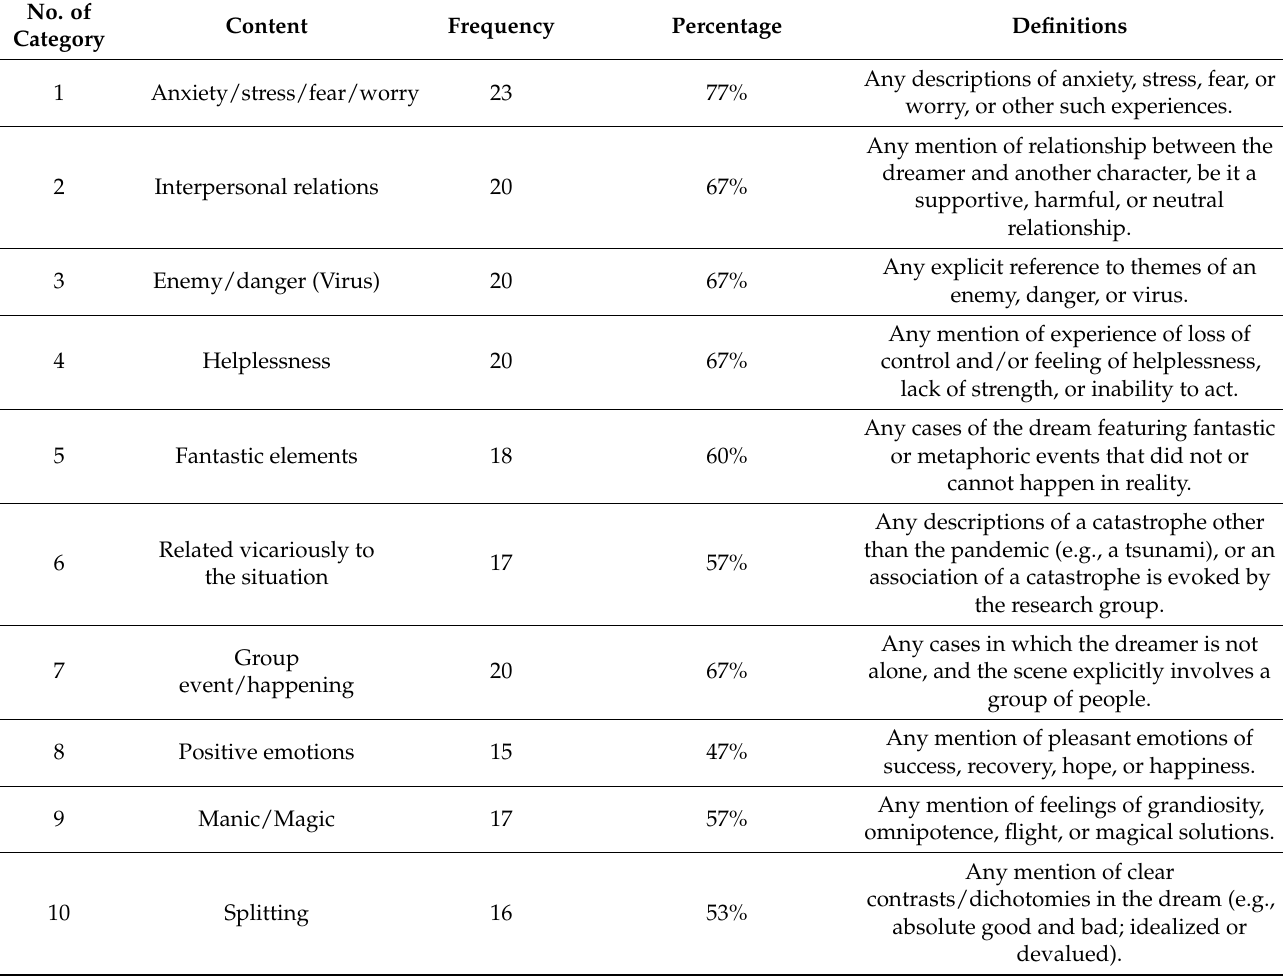
Table A1. Categories extracted from dream content